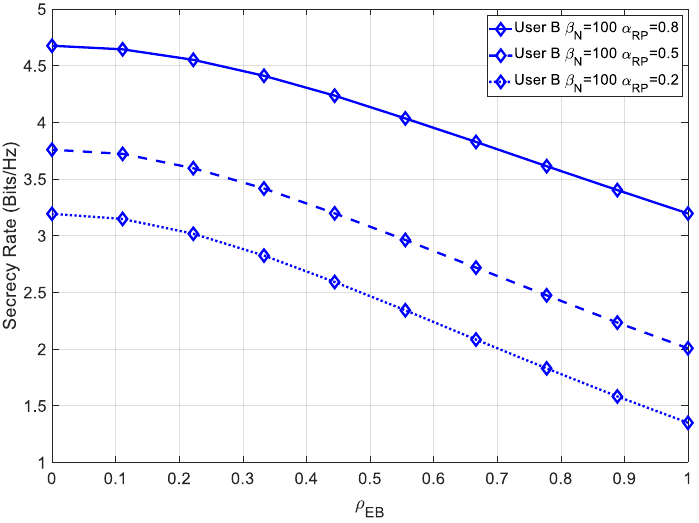
Figure 9. Secrecy rate of the 8 × 8 receiver B with channel estimation errors on both the receiver and eavesdropper, for various ray power